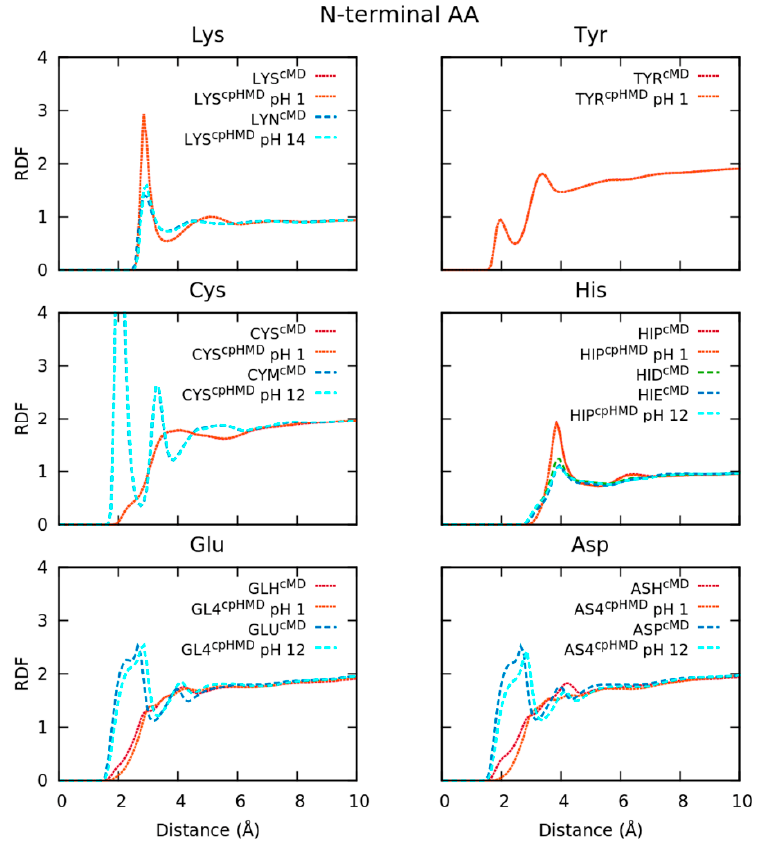
Figure 4. Radial distribution functions (RDFs) of the solvent water molecules around each amino acid of the capped tripeptides. Only the N-terminal amino acid of each tripeptide structure is shown in the plot. Simulations in the protonated form are represented with dotted lines while the deprotonated ones are in dashed lines.